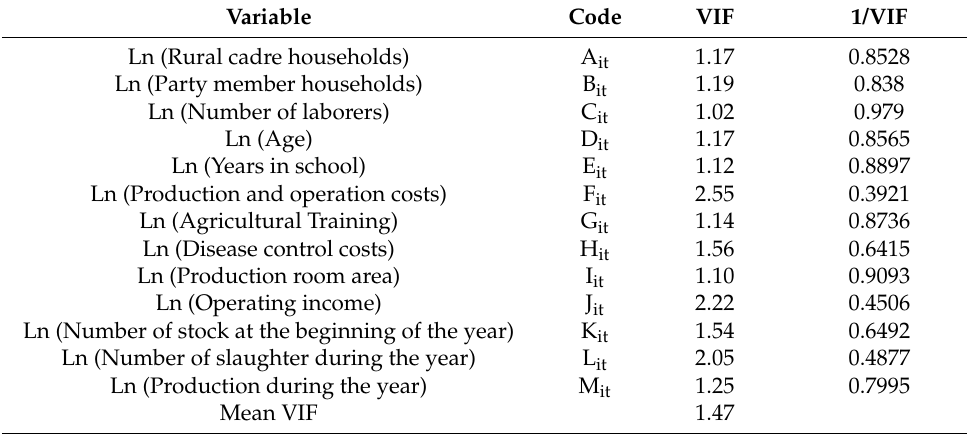
Table 2. Covariance test results.